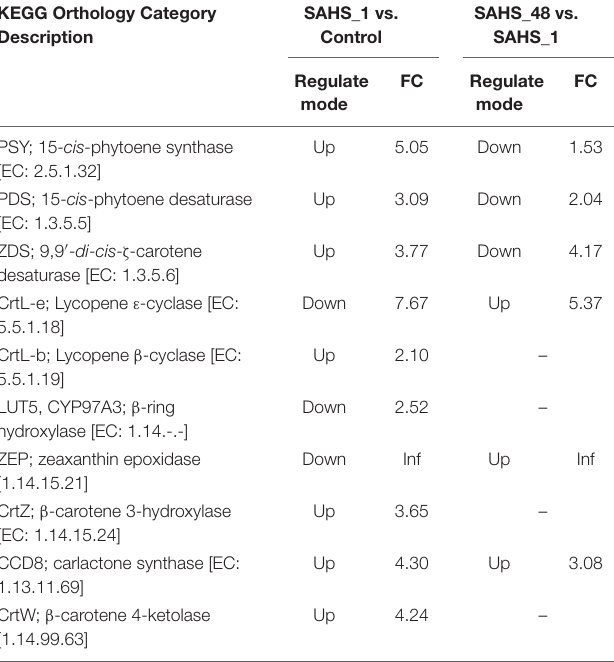
TABLE 6 | The up and downregulated genes related to the carotenoid biosynthesis pathway during SAHS stage transitions. KEGG Orthology Category